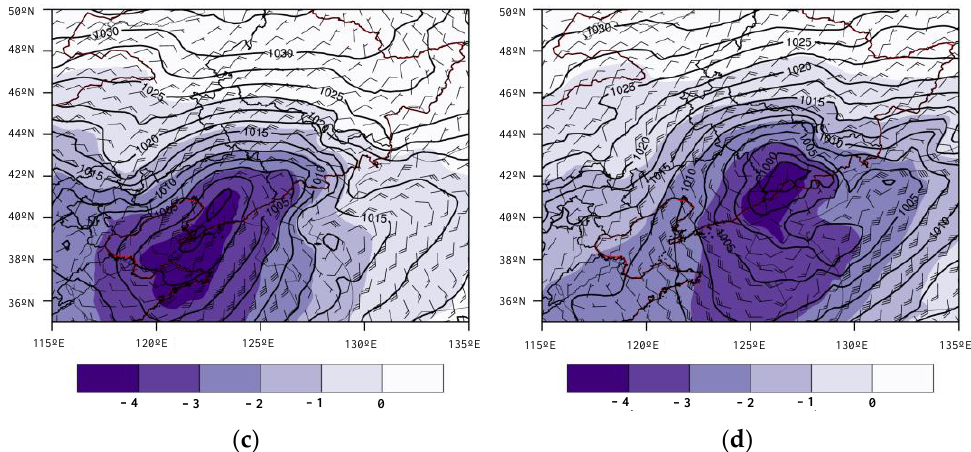
Figure 3. ( a ) 850 hPa height field (isoline) and standardized abnormality (coloring) at 20:00 on 18 November, ( b ) 925 hPa height field (isoline) and standardized abnormality (coloring) at 20:00 on 18 November, ( c ) sea level pressure field (isoline) and standardized abnormality (coloring) at 20:00 on 18 November, ( d ) sea level pressure field (isoline) and standardized abnormality (coloring) at 08:00 on 19 November.